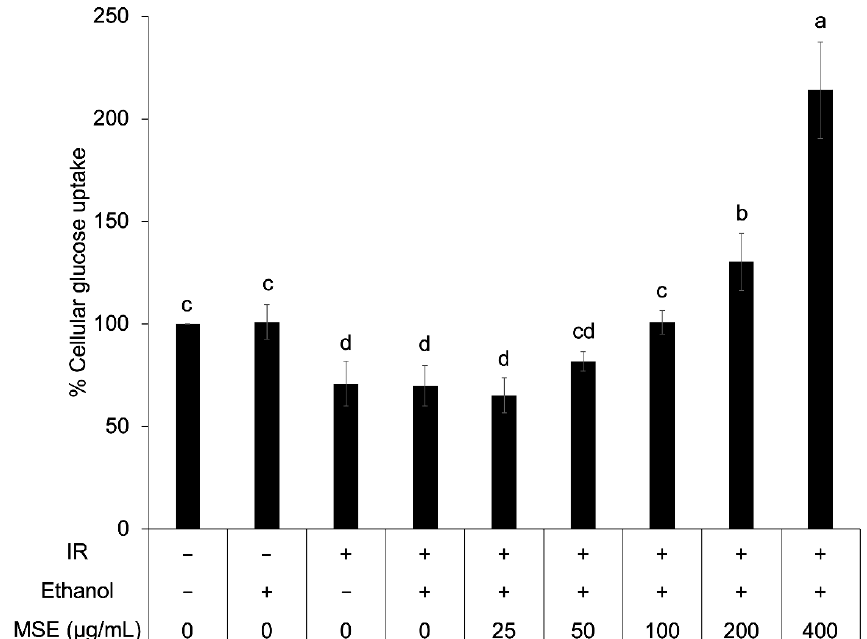
Figure 4. Intracellular reactive oxygen species (ROS) in the control cells and the insulin-resistant cells (IR) with and without mung bean seed coat extract (MSE) treatment. Statistical analyses were performed using Tukey’s posthoc test one-way analysis of variance (ANOVA). Values are expressed as the mean ± SD ( n = 3). Different letters ( a – e ) indicate statistical differences ( p < 0.05). IR is insulin-resistant HepG2 cells.